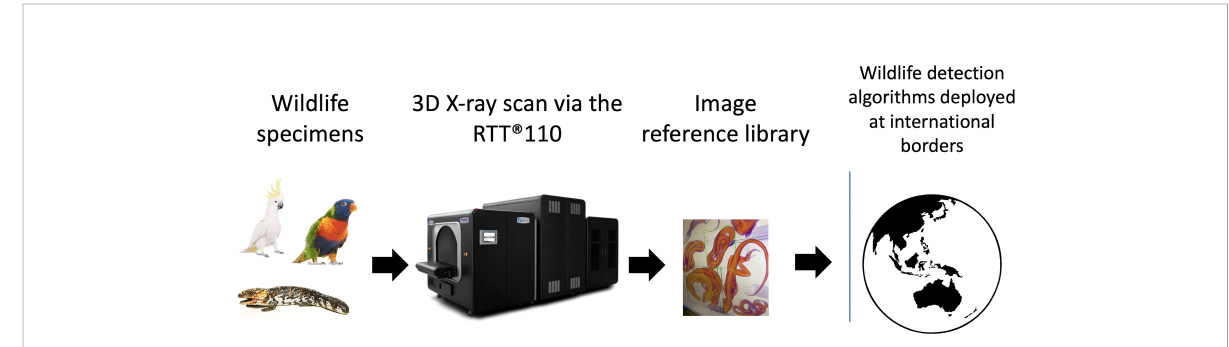
FIGURE 1 Data collection process used to scan Australian wildlife via the use of Real Time Tomography 3D X-ray imaging. All images contribute to a growing image reference library and used to create algorithms for wildlife detection. Algorithms are intended for deployment at Australia ’ s international borders as a complimentary means of wildlife traf fi cking detection. This is in addition to the Australian Border Force and biosecurity sniffer